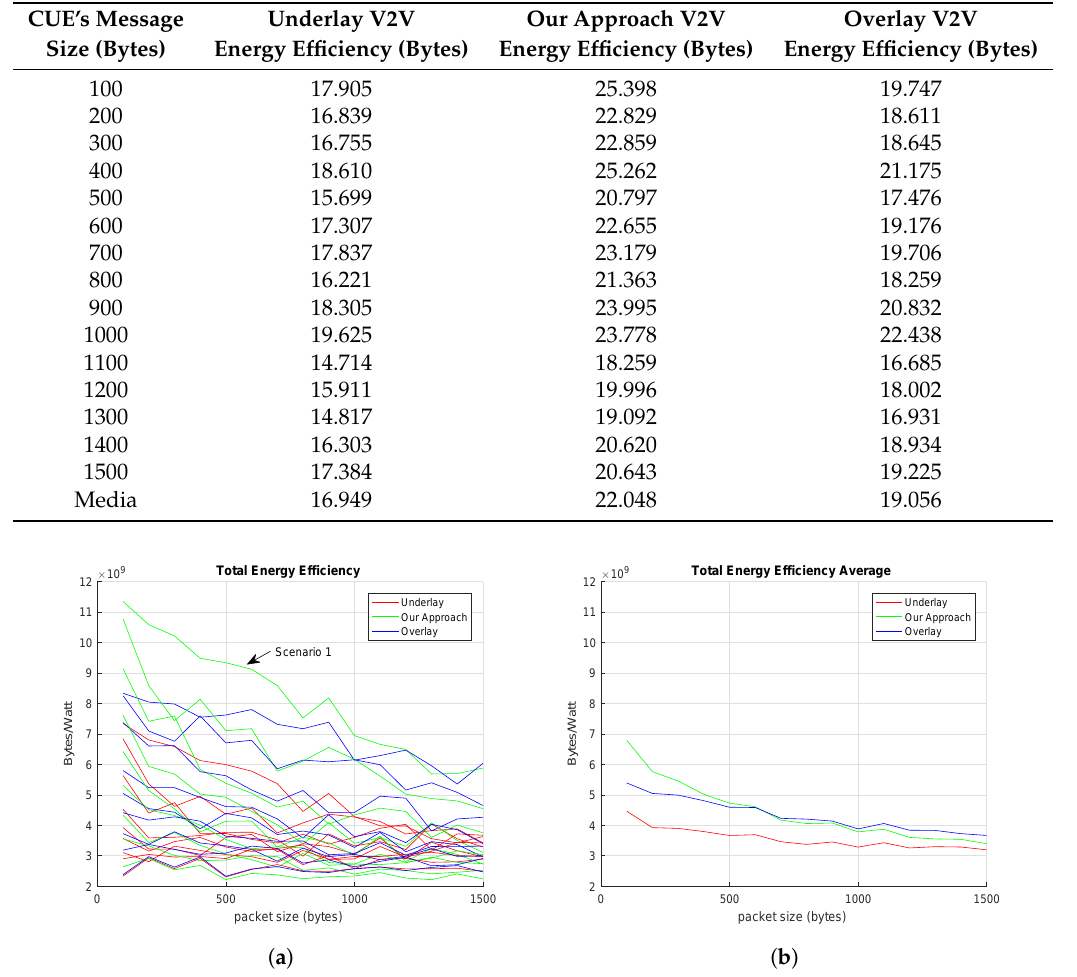
Figure 9. Energy Efficiency offered to V-UEs based on C-UEs’ traffic pattern. ( a ) Total Average Energy Efficiency in different scenarios; ( b ) Total Average Energy Efficiency for all set of